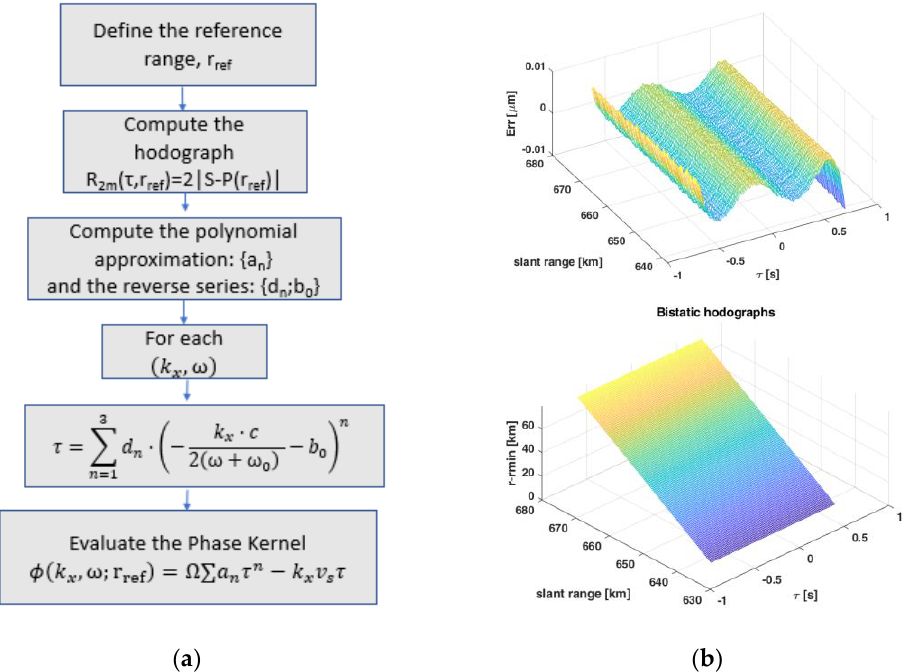
Figure A2. ( a ) Flow chart for the numerical evaluation of the two-dimensional spectrum of the matched phase reference. ( b ) Example of a set of bistatic hodographs ( top ), computed at different slant range, by assuming the mission parameters and ( bottom ) the error due to fitting a fourth-order polynomial.